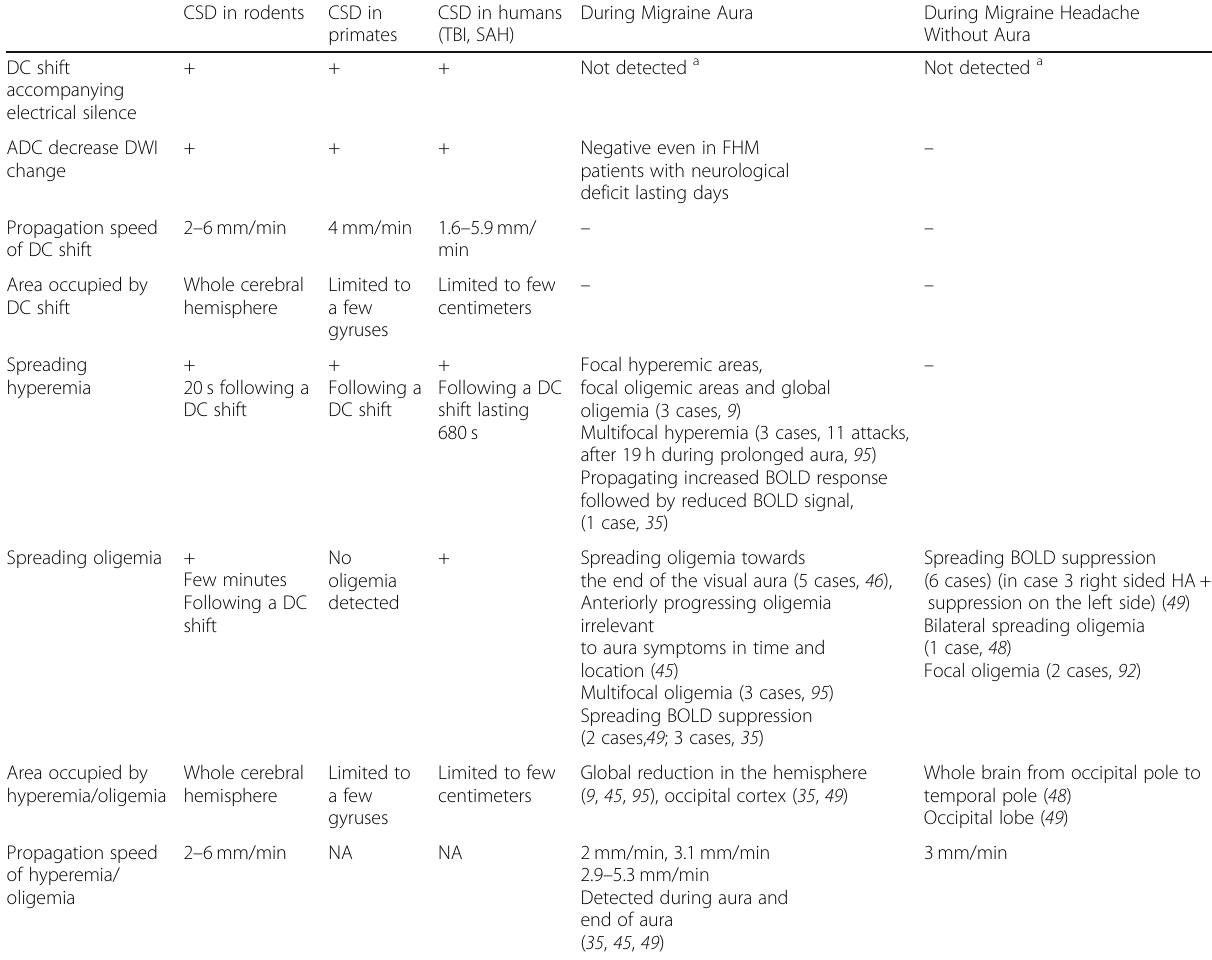
Table 2 Comparison of unique aspects of cortical spreading depression with the findings in migraine CSD in rodents CSD in